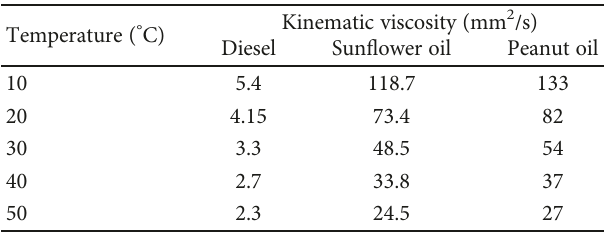
Table 2: Kinematic viscosities of diesel [36], sun fl ower oil [36], and peanut oil [35] at di ff erent